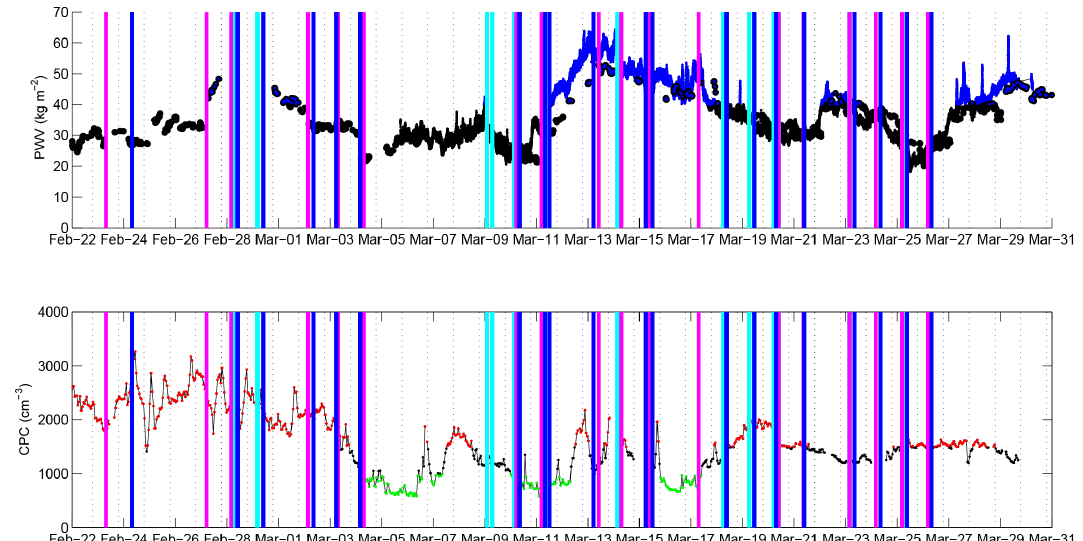
Figure 2. Time series showing the dynamic range of precipitable water vapor (MWR PWV in kgm − 2 , upper panel) and surface aerosol concentration (CPC number concentration in cm − 3 , lower panel) observed during CARDEX. The colors correspond to the regimes described in the text: upper panel shows wet (blue) and dry (black) conditions, and lower panel shows low-pollution (green) and high-pollution (red) conditions. Overlaid vertical lines indicate UAV flight times for the aerosol and radiation (MAC4, magenta), flux (MAC5, blue), and cloud microphysics (MAC6, cyan) planes, showing the wide range of conditions which were sampled.